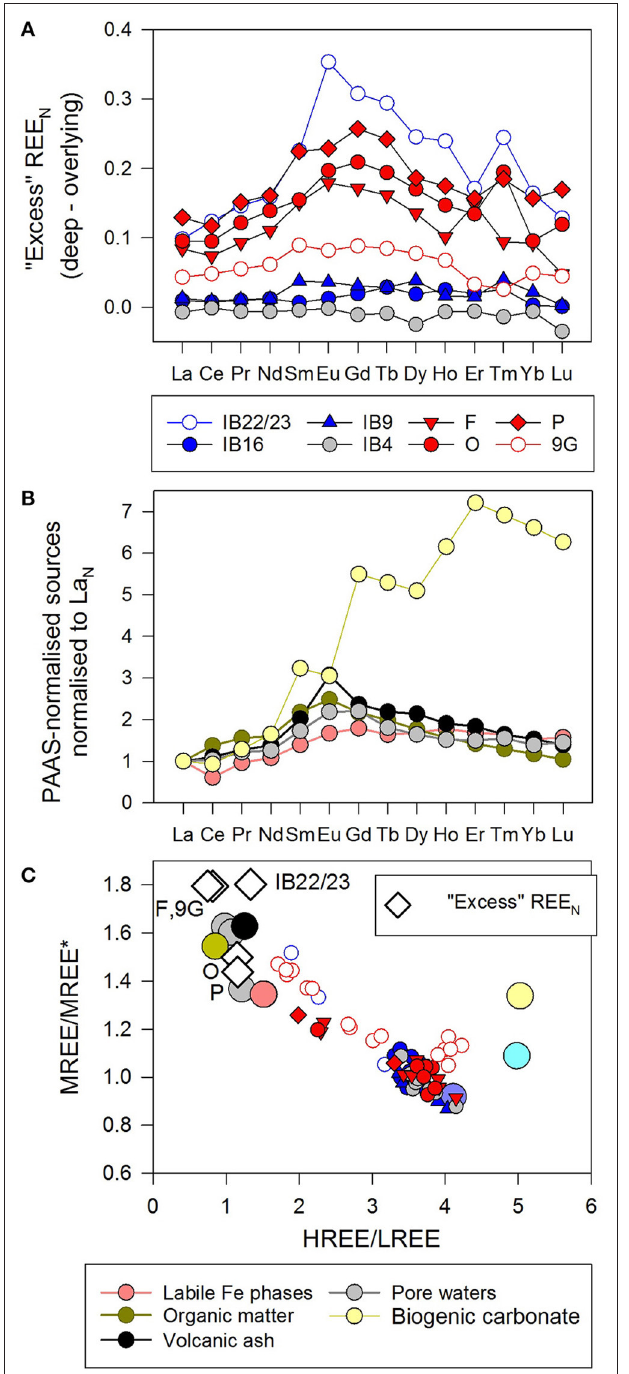
FIGURE 9 | (A) “Excess” REE N in the deepest seawater samples to identify the phase contributing excess REE concentrations to the water column, calculated by subtracting the PAAS normalised REE in the overlying sample from the deepest sample at each of the EEL stations (REE N deepest sample—REE N overlying sample). (B) Potential sources of REE to seawater. (C) The same as Figure 8 , with the addition of the REE composition (MREE/MREE* vs. HREE/LREE) of the “excess” REE at stations F, O, P, 9G, IB22/23. References listed in caption of Figure 8 . To note, surface waters from O and all 9G samples were not filtered.